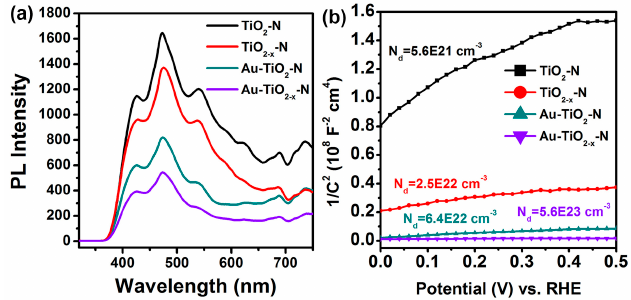
Figure 9. ( a ) Photoluminescence spectra and ( b ) Mott ‐ Schottky plots collected at a frequency of 10 kHz in the dark of various TiO 2 supports and Au ‐ TiO 2 catalysts.